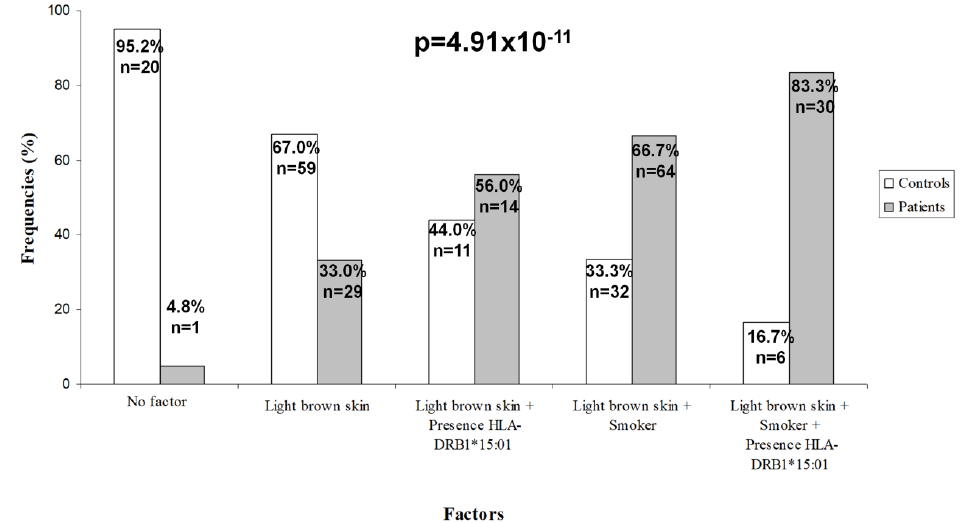
Figure 3. Frequencies for accumulative risk model. Frequencies for each group according to the combination of different risk factors. Table 3. Accumulative risk model .